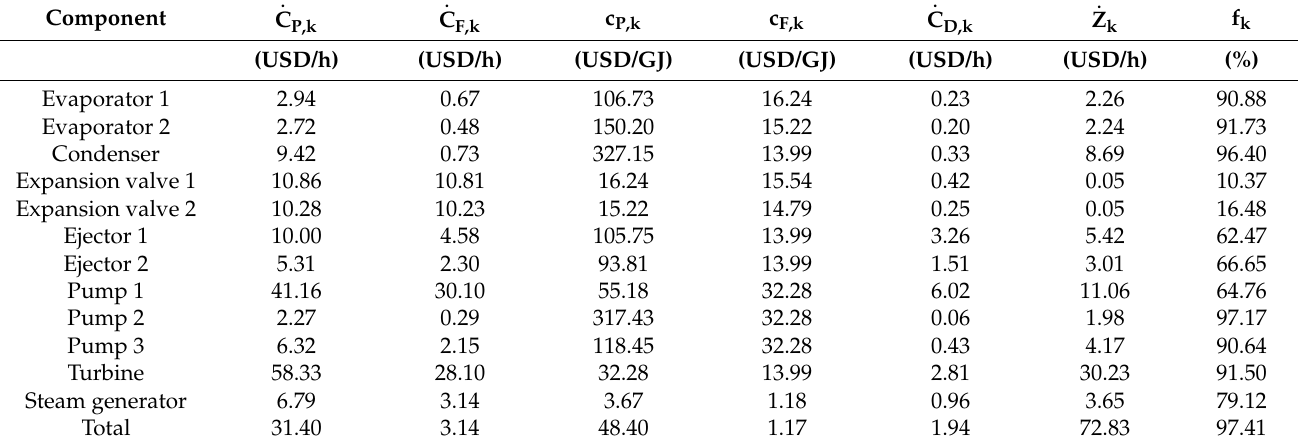
Table 13. Exergoeconomic parameters of the cycle.